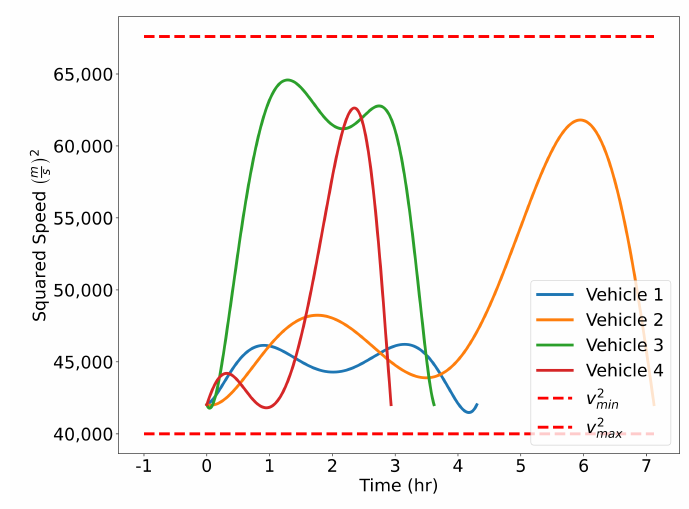
Figure 27. Verifying speed constraints for the Air Traffic Control example.